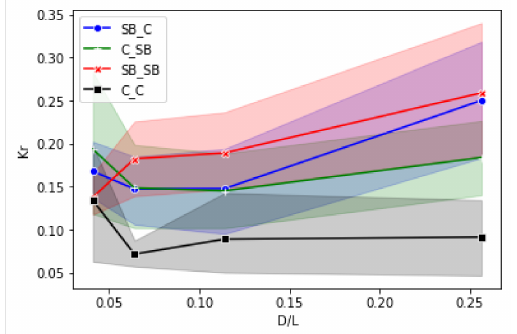
Figure 12. Average Kr trend for all three slopes